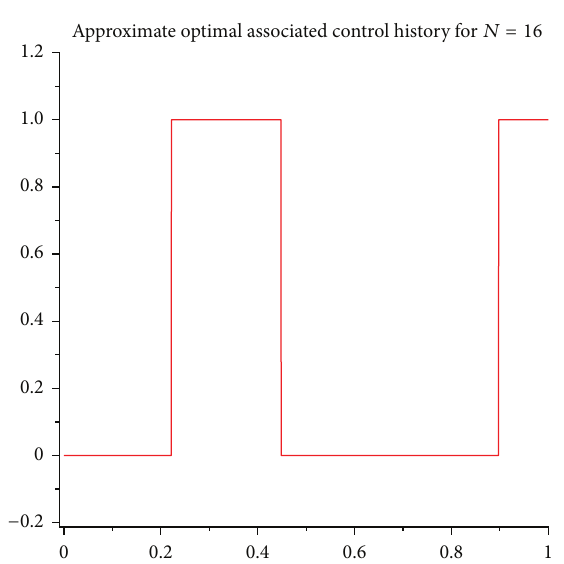
Figure 3: Approximate optimal associated control 𝜆(𝑡) history of Example 2 for 𝑁 = 16 .